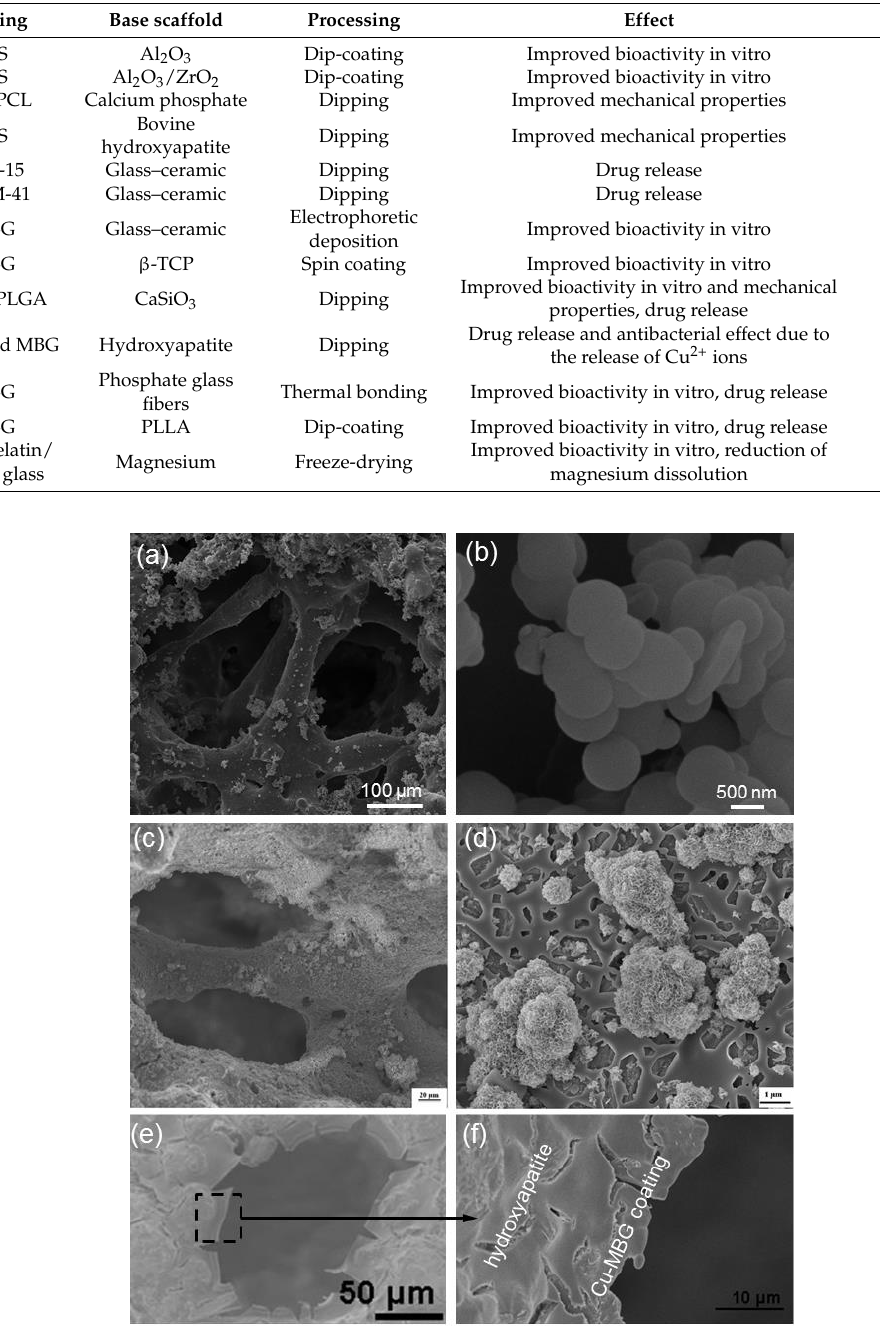
Table 2. Scaffolds provided with a mesoporous coating.